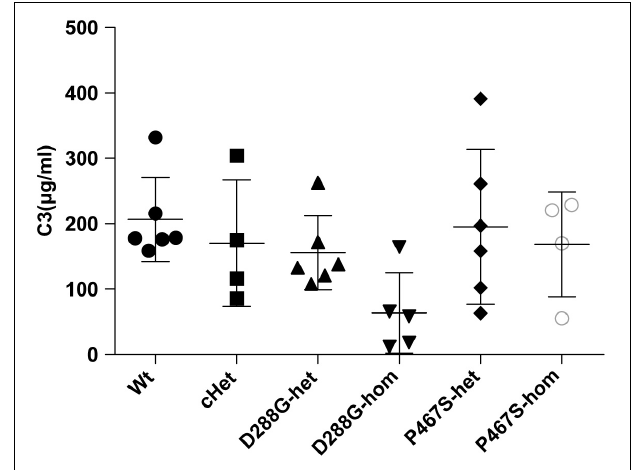
FIGURE 5 | Comparisons of the circulating C3 levels of the groups of mice with different genotypes under the treatment of LPS. The serum C3 level of the D288G homozygote group was lower than that of the other groups, but the differences did not reach any statistical significance ( p = 0.114) according to the ANOVA test. Wt, n = 6; cHet, n = 4; D288G-het, n = 6; D288G-hom, n = 5; P467S-het, n = 6; P467S-hom, n = 4.